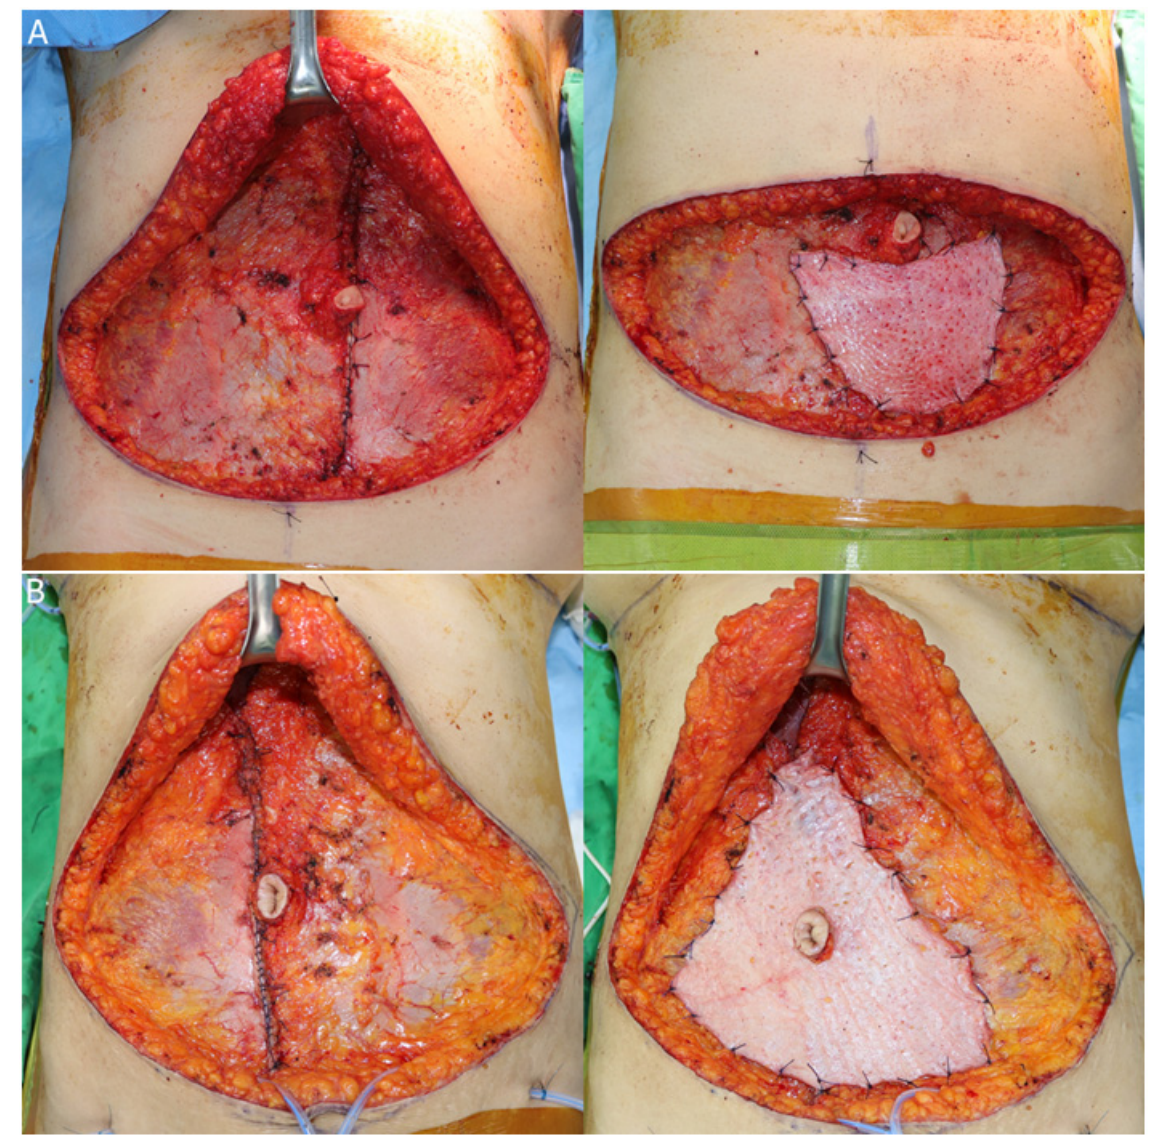
Figure 1. Onlay dermal autograft from discarded zone IV tissue in the TRAM flap: ( A ) Direct closure was performed on both sides of the fascia in a horizontal-mattress fashion following flap elevation. The dermal onlay graft harvested from the discarded flap was stretched over the fascia on which the direct closure was performed. ( B ) An incision was made on the dermis at the site of the umbilicus through which the umbilical stalk was passed.